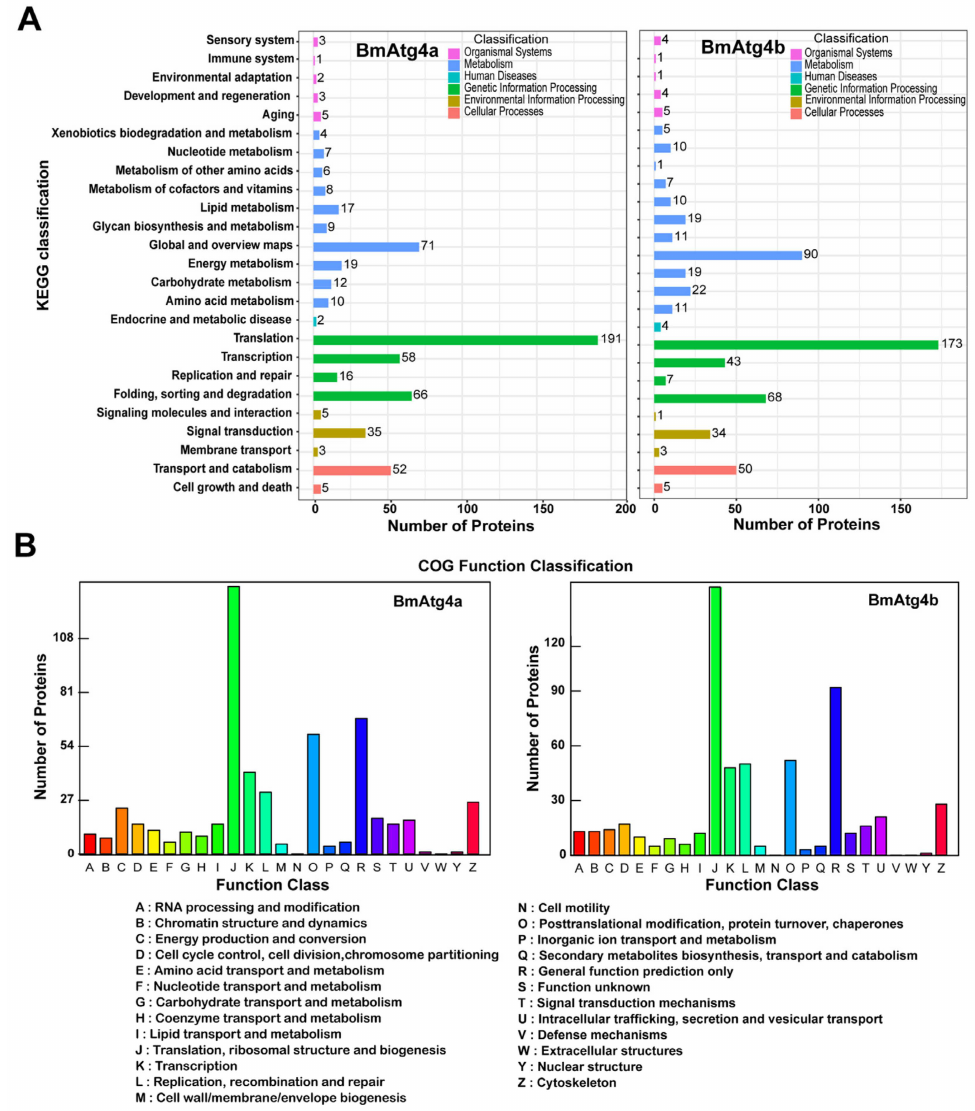
Figure 5. KEGG and COG analysis of BmAtg4a- and BmAtg4b-immunoprecipitated proteins. KEGG functional annotation ( A ) and COG annotation ( B ) of the proteins identified by mass spectrum in the immunoprecipitate of BmAtg4a-His and BmAtg4b-HA. 3.5. BmACT1 and BmACT2 Are Required for the Autophagic Functions of BmAtg4b and